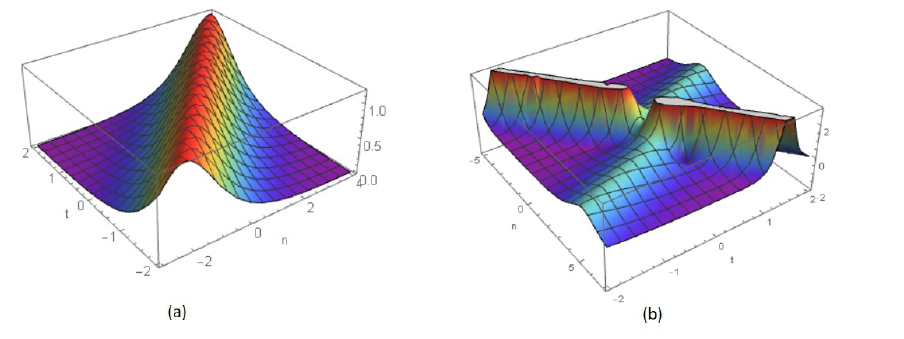
Figure 1. Plots of the absolute value | Φ ( n , t ) | 2 of the soliton solutions of semidiscrete cmKdV, focusing case: 1-ss (a) and 2-ss (b) for the chosen parameters: (a) k 1 = 1 + 4 i , (b) k 1 = 1 + i and k 2 = 2 + 3